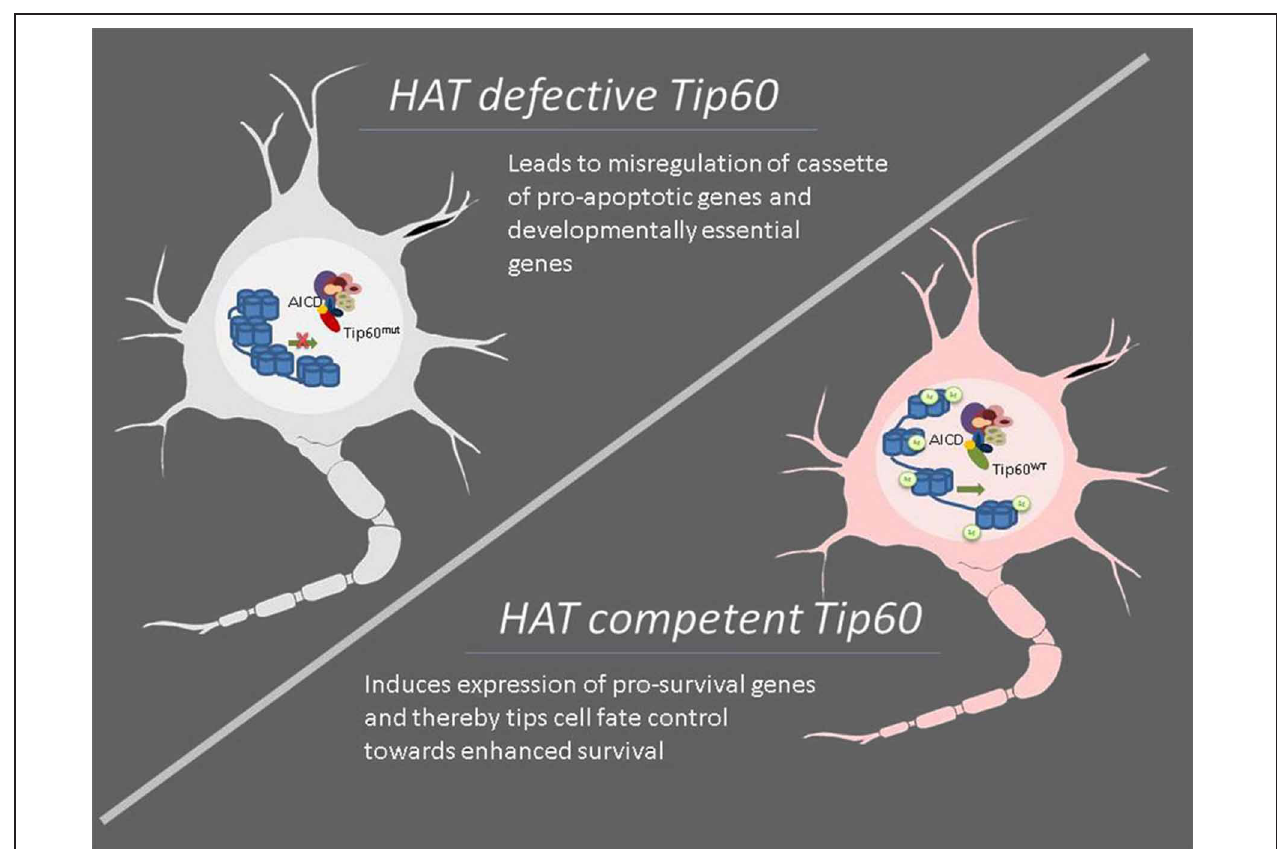
neuroprotective effects as evidenced in the case of Tip60. Under amyloid precursor protein (APP) induced neurodegenerative conditions, HAT competent Tip60 (Tip60 WT ) but not its HAT defective counterpart (Tip60 mut ) exerts neuroprotective defects by complexing with the APP intracellular and epigenetically regulating gene expression profiles essential for tipping the cell fate control balance in favor of cell survival. Thus, targeting specific HATs for therapeutic intervention may offer more promising alternatives for neurodegenerative diseases than currently available HDAC